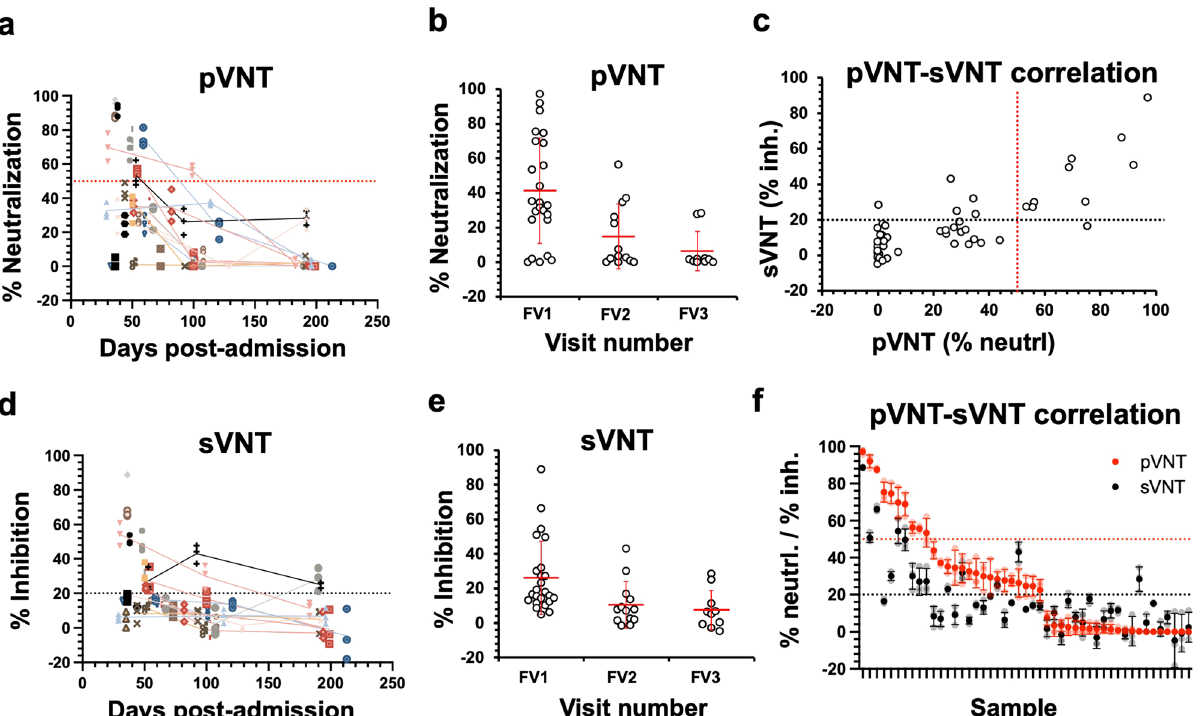
Fig. 3 Comparison of COVID-19 neutralizing antibodies (NAb) status from convalescents samples between pseudovirus neutralization test (pVNT) and surrogate virus neutralization test (sVNT) methods. Evaluation of NAb status from COVID-19 convalescent samples at different time points post infection from different follow up visits (FV) using ( a , b ) pVNT and ( d , e ) sVNT. Data shown in ( a , d ) were mean ± standard deviation (SD) of % neutralization for pVNT and mean ± SD% inhibition for sVNT, respectively. Each data points were performed in triplicates. Lines connecting different data points represented samples that were obtained from the same subjected collected at different time points. Data shown in ( b , e ) were mean values of % neutralization for pVNT and % inhibition for sVNT from different samples. c Correlation between sVNT and pVNT. Mean values from each data point were represented on the graph. f Alternative correlation plot between sVNT and pVNT where data were arranged from highest to lowest values of pVNT neutralization percentages. Data were represented as mean ± SD. Red and black dotted lines represent cut-off values at 50% and 20% for pVNT and sVNT, respectively, to distinguish positive and negative NAb